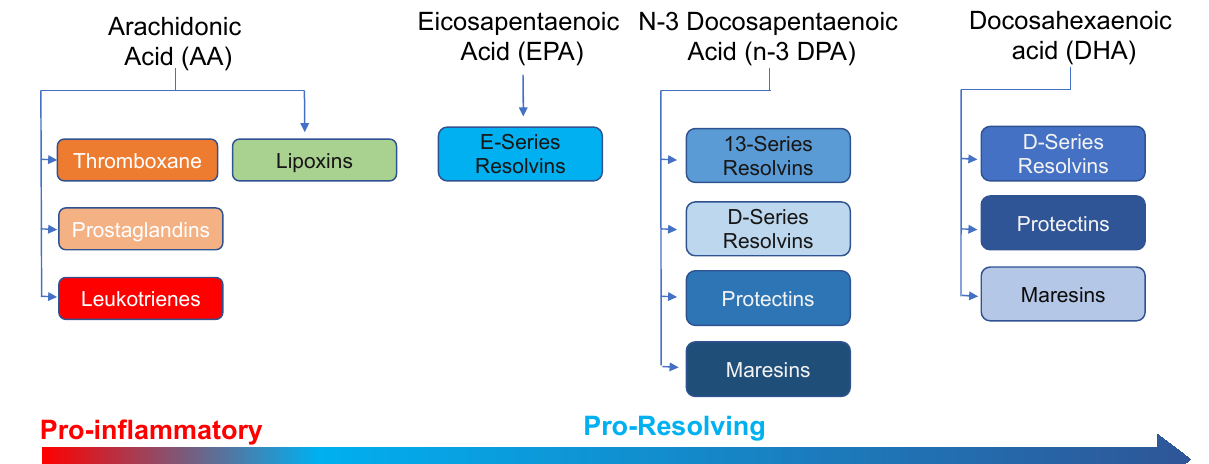
Figure 1. Role of lipid mediators in the initiation and resolution of inflammation.